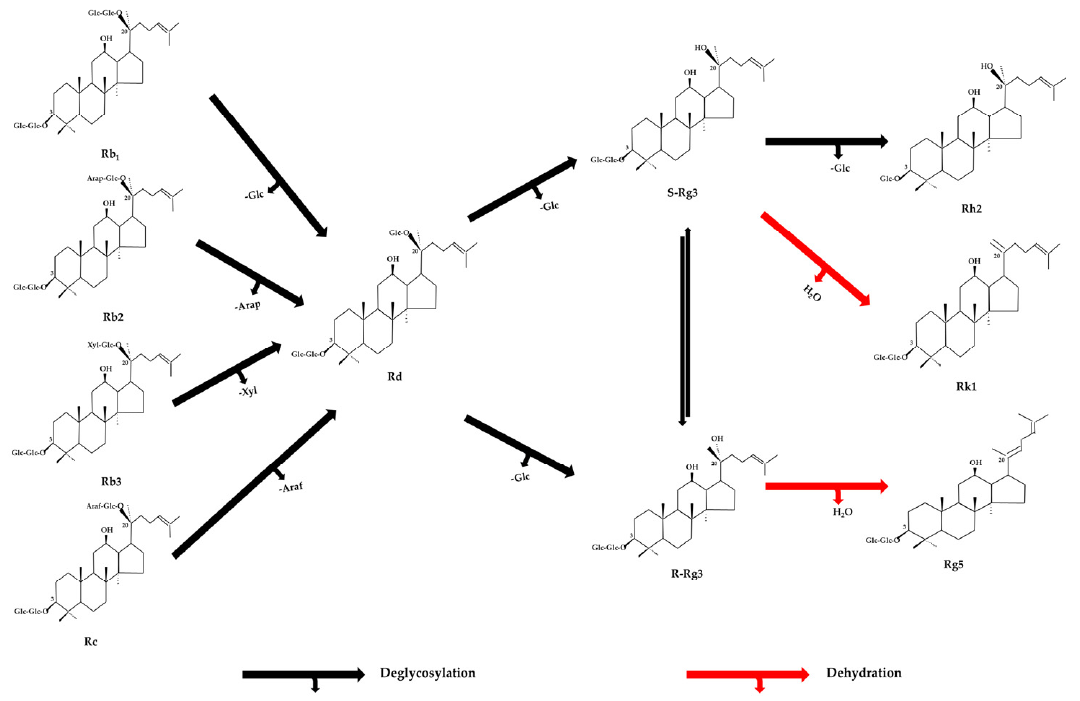
Figure 4. Transformation trends of PPD-type ginsenosides.